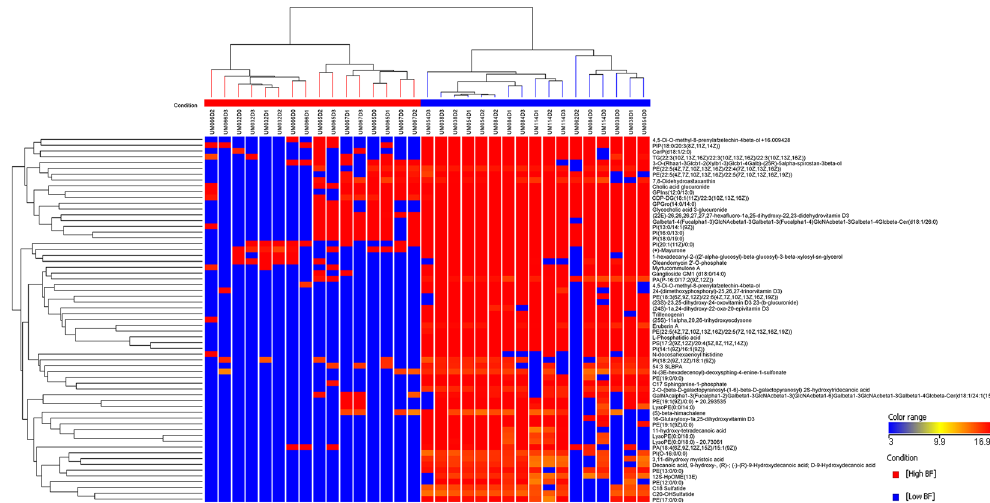
Figure 3. Heat map and clustering presenting metabolomic profiles of low and high biofilm-formers based on 65 significantly different lipids. The heat maps and clustering based on Euclidean distance were generated using MPP. Features with p-value < 0.005 were considered to be significantly different between low and high biofilm- formers. Details of these lipids are listed in Suppl. Table